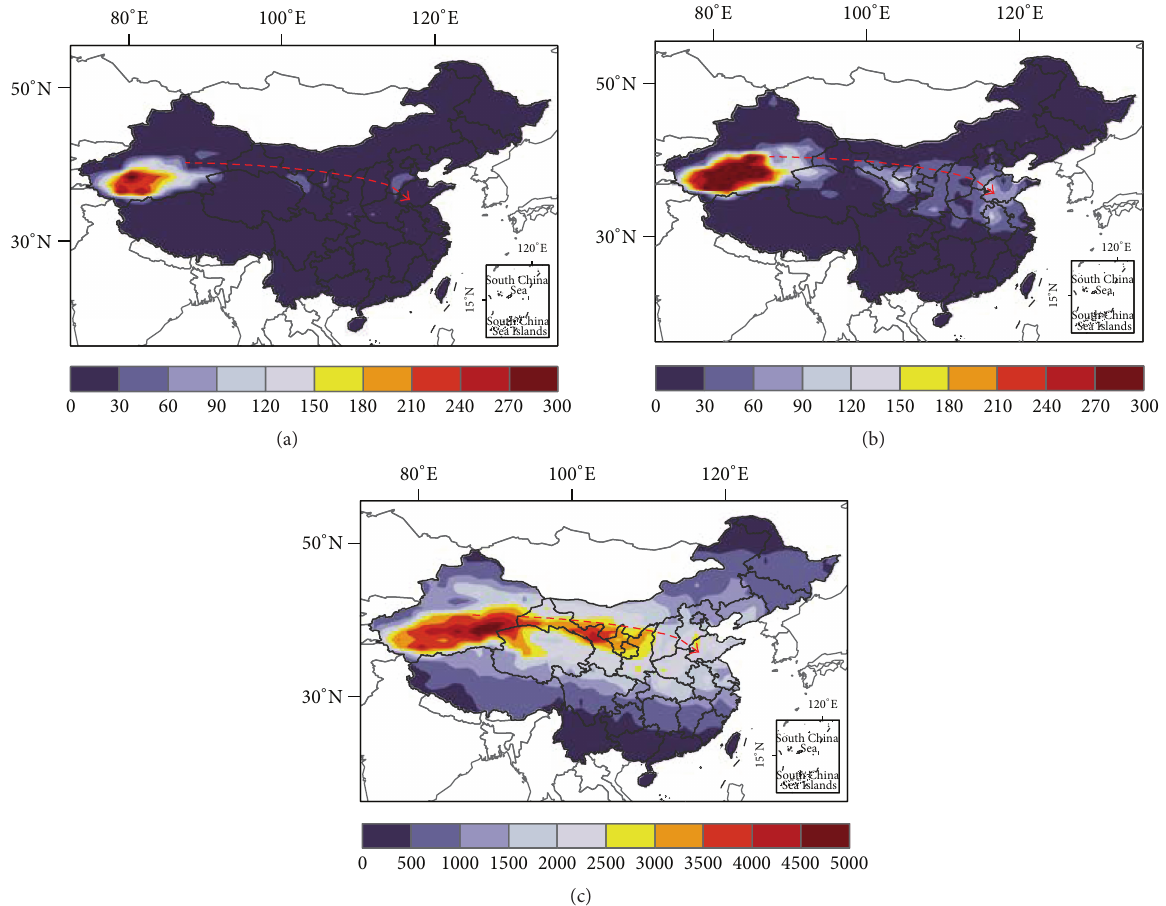
Figure 1: Spatial distribution maps of 8-year (2007–2014) total occurrence days of dust over China as observed from CALIOP. (a) Heavy dust loading (or dust storm) event. (b) High dust loading event. (c) Light (or moderate) dust loading event. Red dashed line represents the most prevailing dust transport path of